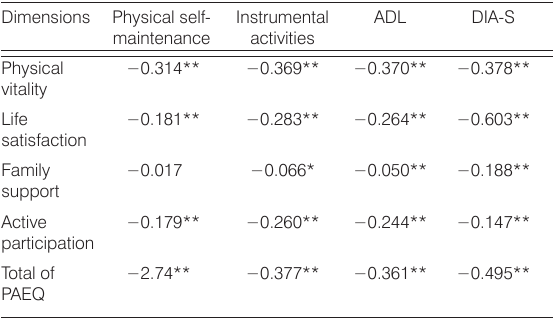
Table 6. Correlation analysis for ADL, DIS-A, and PAEQ (N =